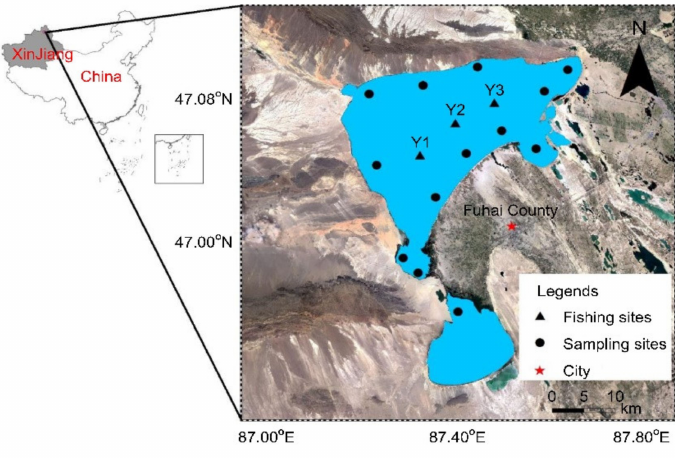
Figure 1. Wulungu Lake and location of the sampling